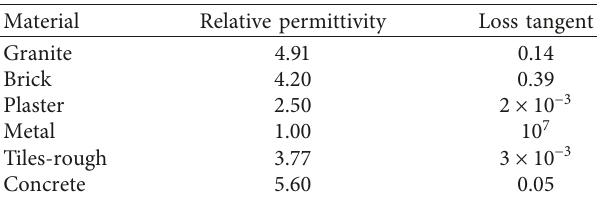
Table 2: Material parameters.